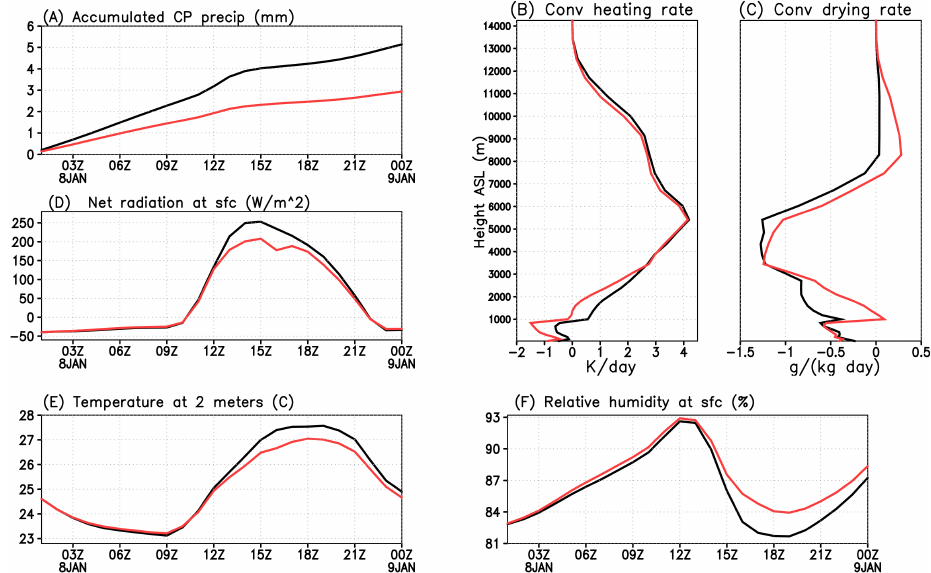
Figure 16. Various panels displaying results for clean (black) and polluted (red) conditions. Shown are accumulated precipitation (A) , vertical profiles of heating (B) and drying (C) rates, net radiation at the surface (D) , 2m temperature (E) and relative humidity at the surface (F)